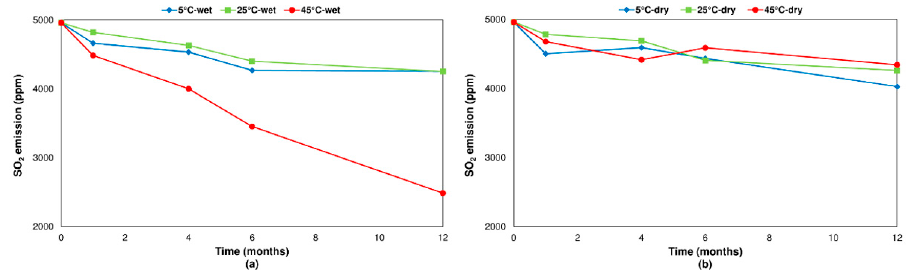
Figure 4. Sulfur dioxide emission area of the chalcopyrite composition at 200–600 ° C in ( a ) a wet environment and ( b ) a dry environment .